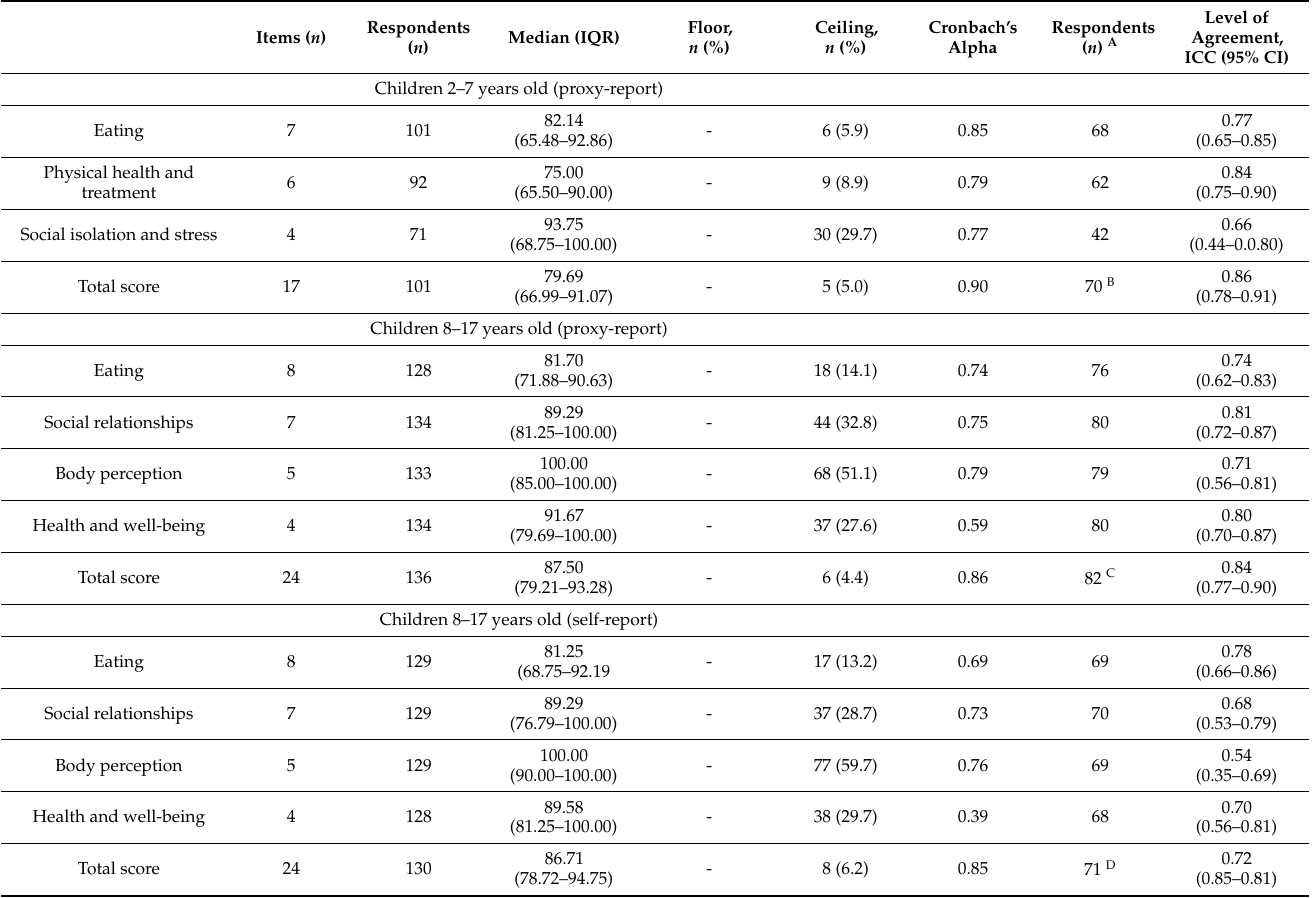
Descriptive values of the EA-QOL©